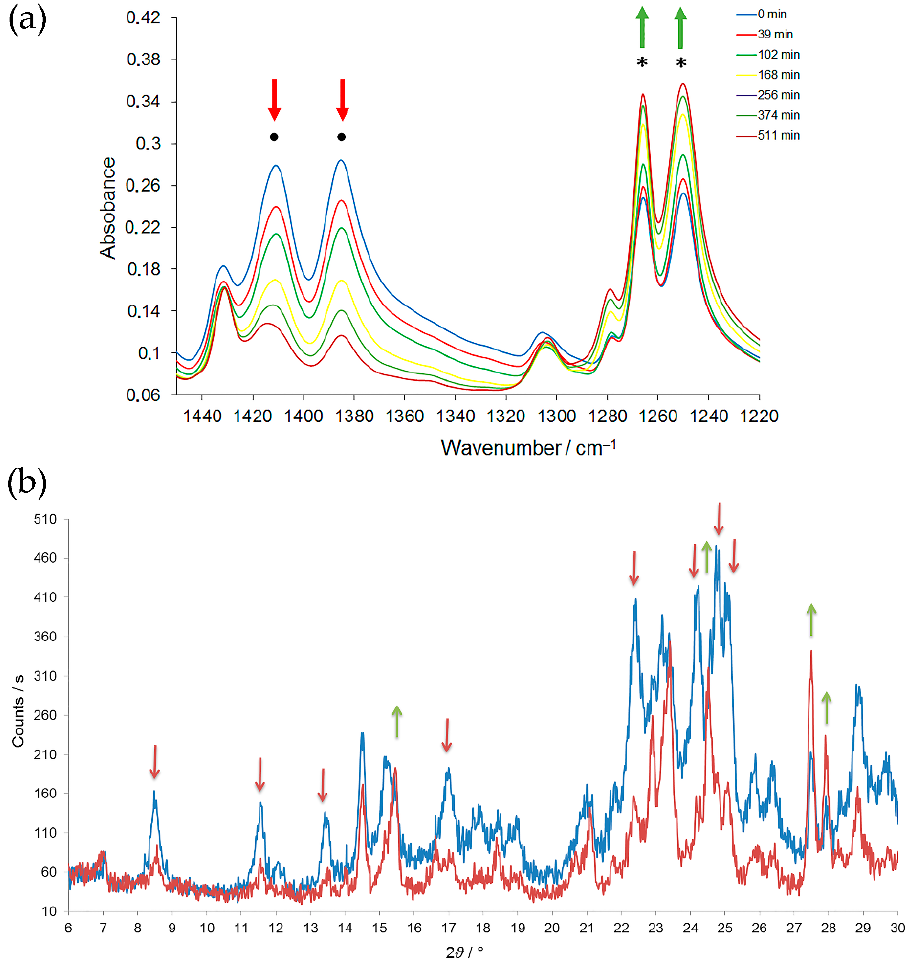
Figure 6. Solid-state Z - E interconversion of azodioxides of m -chloronitrosobenzene monitored by ( a ) FTIR spectroscopy at 299 K (the characteristic signals of Z - and E -isomers are labeled with • and * , respectively) and by ( b ) XRPD at 298 K (X-ray diffraction patterns at the beginning of the reaction are shown in blue and after 18 h in red). Reproduced with permission from [29]. Copyright 2016 Wiley-VCH.